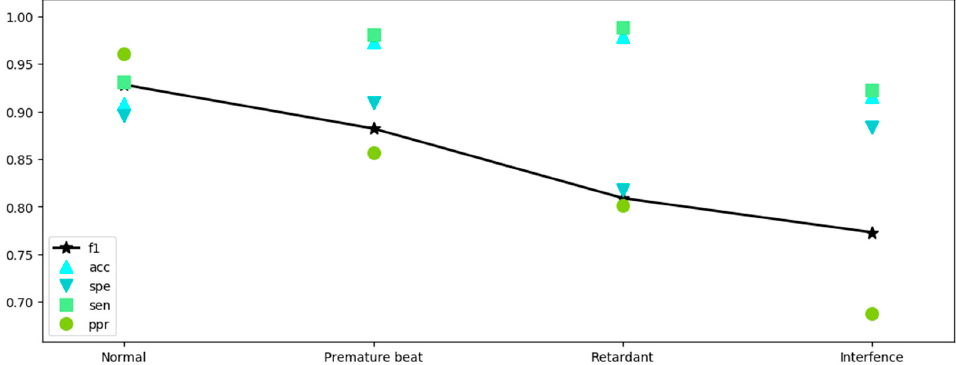
Figure 8. Visualization of the simulation results. Electronics 2020 , 9 , x FOR PEER REVIEW